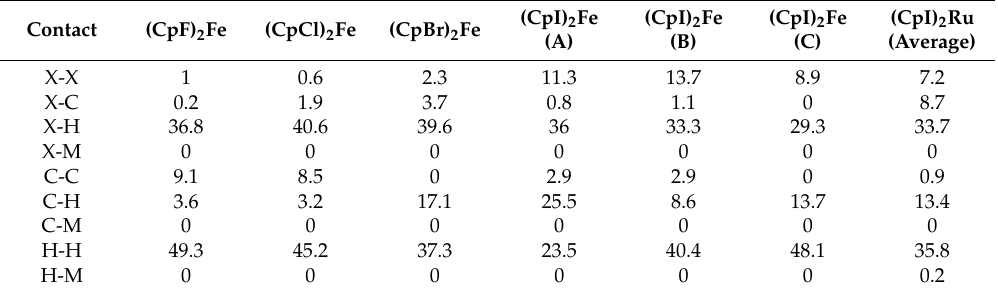
Figure 4. Hirshfeld surfaces for the four inequivalent molecules in the asymmetric unit of (CpI) 2 Ru. Table 2. Contribution (in percentage) to the Hirshfeld surface area of the various intermolecular